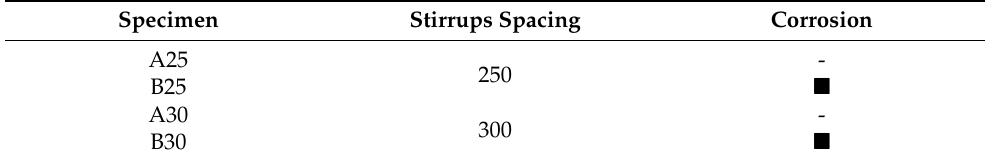
Table 1. Layout of experimental program.